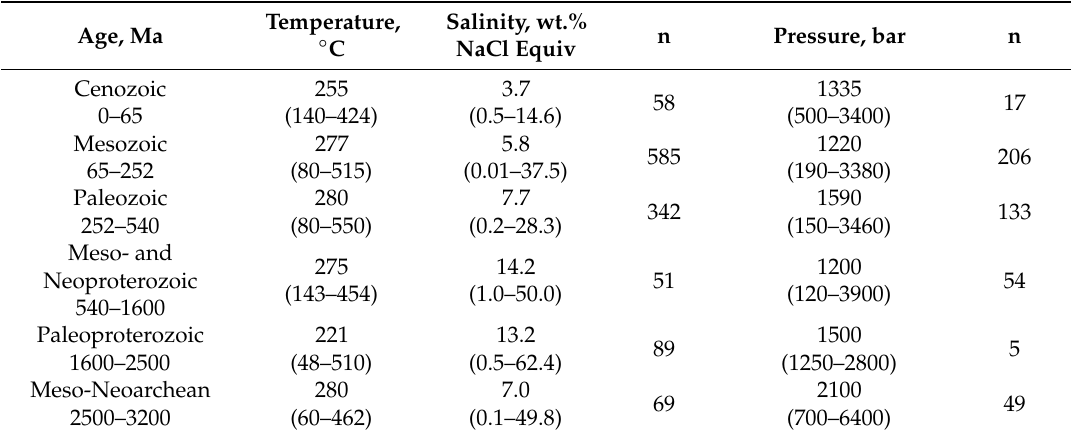
Table 9. Median values of main physicochemical parameters of mineral-forming fluids of large ( ≥ 100 tonnes Au) orogenic gold